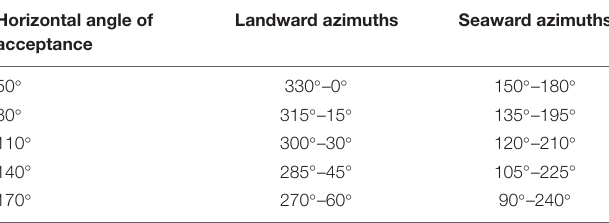
TABLE 1 | Horizontal angles of acceptance and the associated azimuths over which the horizon profile, SQM, and illuminance data were aggregated to construct predictor variables.